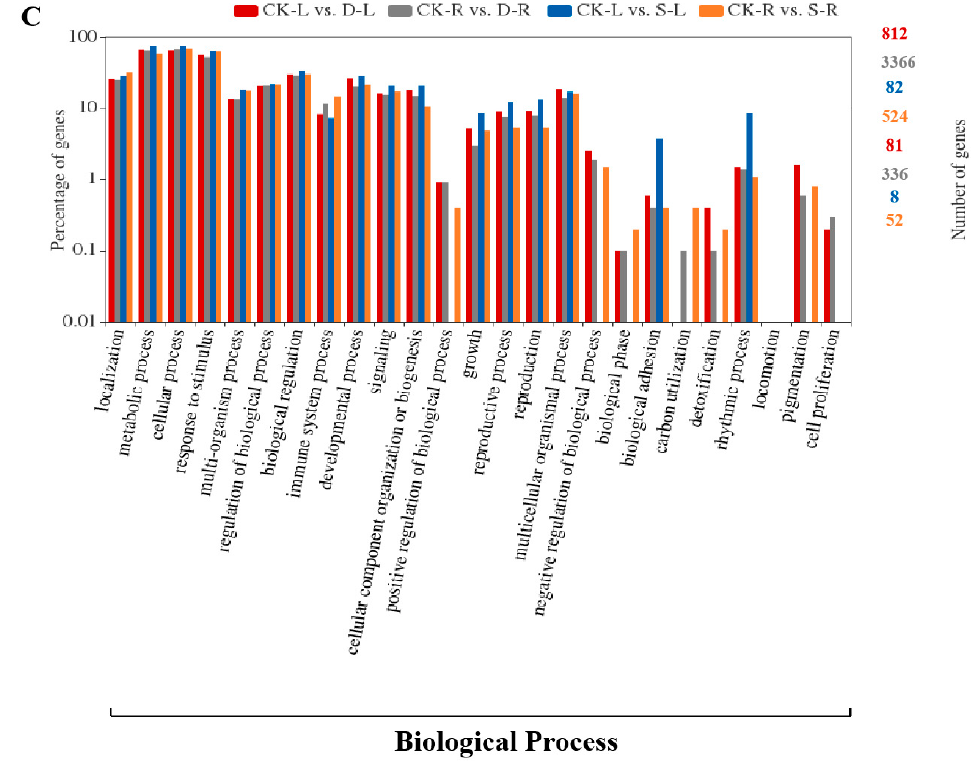
Figure 3. Gene ontology (GO) functional classification of DEGs from four treatment groups in B. napus . A total of 4784 DEGs were classified into GO terms from three ontologies involving cellular components ( A ), molecular function ( B ), and biological processes ( C ). CK-L (CK, leaves) vs. D-L (drought, leaves), CK-R (CK, roots) vs. D-R (drought, roots), CK-L vs. S-L (salinity, leaves), CK-R vs. S-R (salinity, roots) represent DEGs under these two abiotic stresses. The y-axis on the right indicates the number of genes in each category. The y-axis on the left indicates the percentage of specific genes in each category.